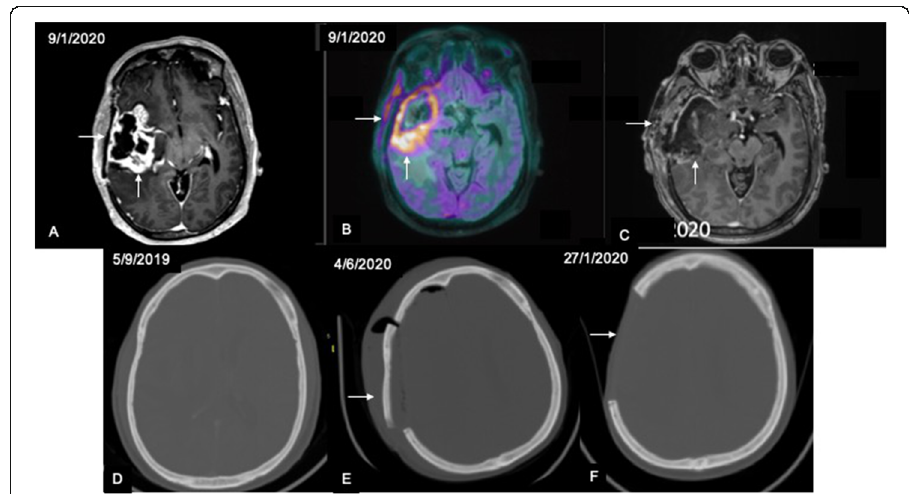
Fig. 8 Sequence of images showing false positive C11 methionine uptake in acute inflammatory pathology: Axial post-contrast T1 MPRAGE ( A ) in a case of suspected recurrence shows parenchymal enhancement (vertical arrow) suggestive of recurrent lesion with associated enhancement of the overlying bone and soft tissues (horizontal arrow). C11 methionine PET image fused with axial T1 MPRAGE ( B ) shows tracer uptake along the bone and soft tissues (horizontal arrow) in addition to parenchymal uptake (vertical arrow). Here the uptake in the bone and soft tissues occurred due to osteomyelitis. Follow-up axial post-contrast T1 MPRAGE following chemo/radiotherapy ( C ) shows reduction in parenchymal enhancement (vertical arrow) with persistent enhancement in bone and soft tissues (horizontal arrow). Sequential axial CT brain images in bone window ( D – F ) show initial scan ( D ) with normal bone followed by progressive osteomyelitis in E and excision of the infected bone in